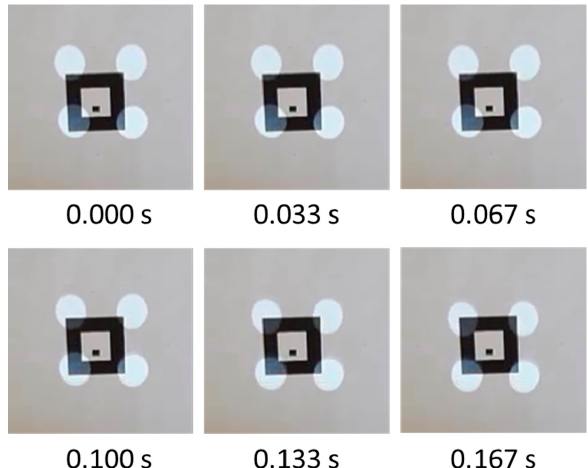
Figure 12. A sequence of photographs around the marker from when the participant stopped his head after moving his head from the center to the top.